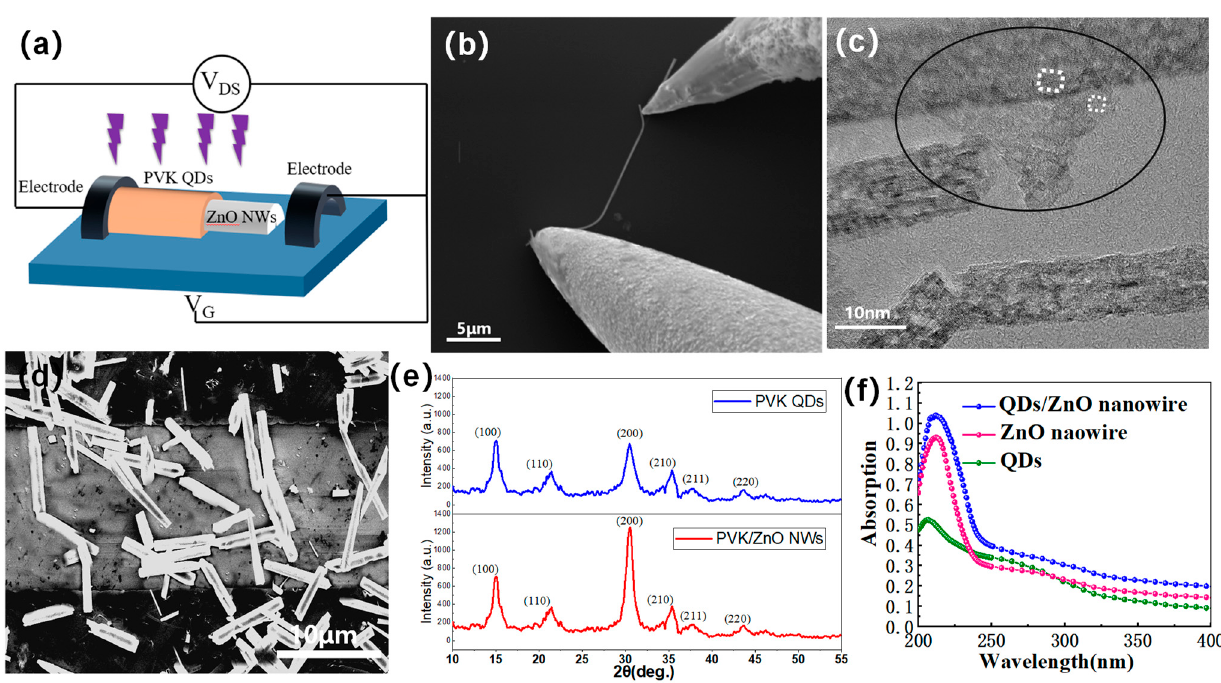
Figure 1. ( a ) Structure of the nanowire-PT; ( b ) SEM image of a single QDs/ZnO nanowire with PVK QDs; ( c ) TEM image of the QDs/ZnO nanowire; ( d ) SEM image of the PT’s channel; ( e ) XRD image of the PVK QDs and QDs/ZnO nanowire; ( f ) absorption spectroscopy of the QDs/ZnO nanowire, ZnO nanowire, and PVK QDs.